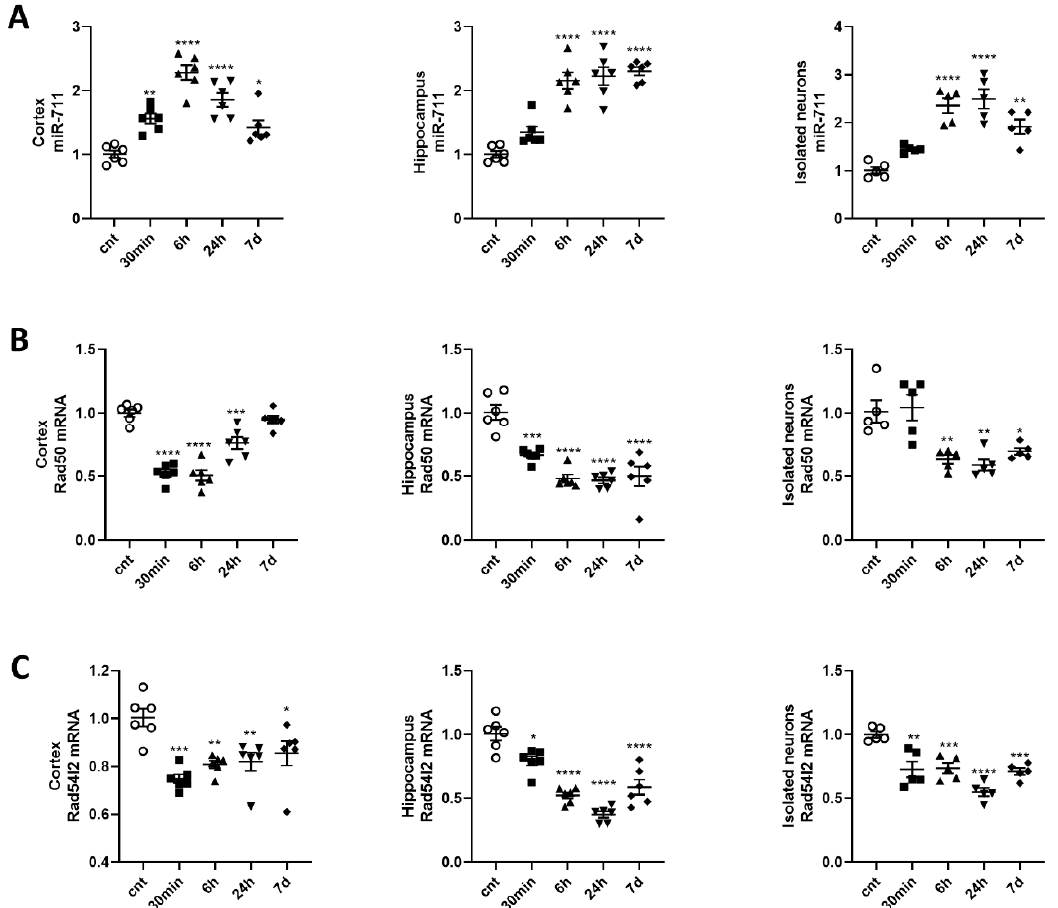
Figure 2. Expression of miR-711 is upregulated, while expression DNA-repair genes is downregulated, in the cortex, hippocampus and purified neurons after brain irradiation. Experimental rationale and details are described in Experimental Setup. Tissues and neurons were collected at 30 min, 6 h, 24 h and 7 d after 10Gy whole-brain irradiation. Total RNA was used for qPCR analysis. qPCR quantification of ( A ) miR-711 in cortex (F(4,25) = 24.46), hippocampus (F(4,25) = 34.3), and isolated neurons (F(4,20) = 20.88); ( B ) Rad50 mRNAs in cortex (F(4,25) = 41.65), hippocampus (F(4,25) = 23.99) and isolated neurons (F(4,20) = 10.74); ( C ) Rad54l2 mRNAs in cortex (F(4,25) = 7.513), hippocampus (F(4,25) = 35.05) and isolated neurons (F(4,20) = 17.2). n = 6 / group for tissues, n = 6 / group for isolated neurons, with 2 technical replicates. * p < 0.05, ** p < 0.01, *** p < 0.001, **** p < 0.0001 vs. control animals non irradiated animals.